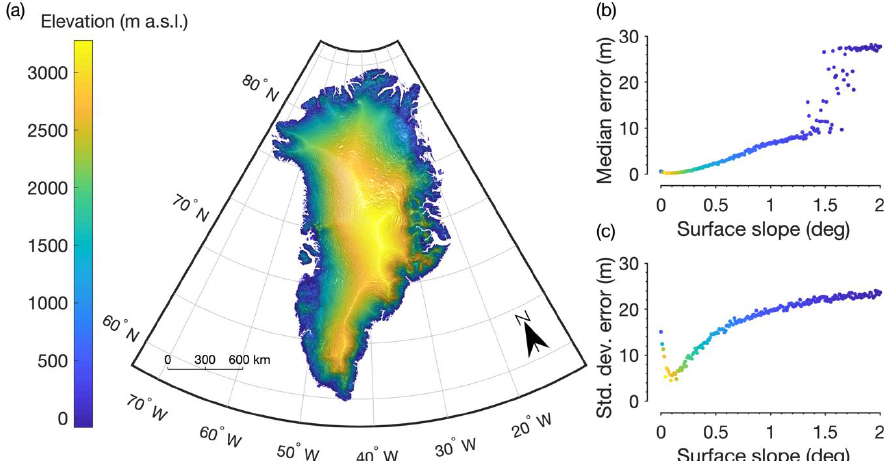
Figure 1. ( a ) Digital elevation model (DEM) of the Greenland Ice Sheet surface created from the European Space Agency (ESA) level 1B CryoSat-2 radar altimetry waveform product [93], with slope indicated by shaded relief; ( b ) median error (difference between CryoSat-2 DEM and ICESat elevations) vs. surface slope, with elevation indicated by colormap in (a); ( c ) standard deviation of error vs. surface slope, with elevation indicated by colormap in (a). The median and standard deviation of error are calculated from the CryoSat-2 DEM error grid binned by a slope with a 0.01 o bin size, following Helm et al. [93] (Figure 9). The median and standard deviation of error increase with slopes with a step shift toward higher error at slopes >1.5 o . Elevation and slope values calculated from the DEM indicate that 16% of the ice sheet area has a surface slope >1.5 o , and nearly all (95%) such areas have elevation <2000 m a.s.l., which is generally representative of the ablation zone (calculations performed by the first author). The error grid was produced by first calculating elevation differences between the CryoSat-2 DEM and individual ICESat elevations (campaign 3F, 3G, and 3H), corrected for elevation change between the individual ICESat observation and the DEM reference time (1 Jul 2012) and then calculating a weighted error as a function of surface roughness, surface slope, and number of cross-validation data points [93]. The DEM and associated error grid are